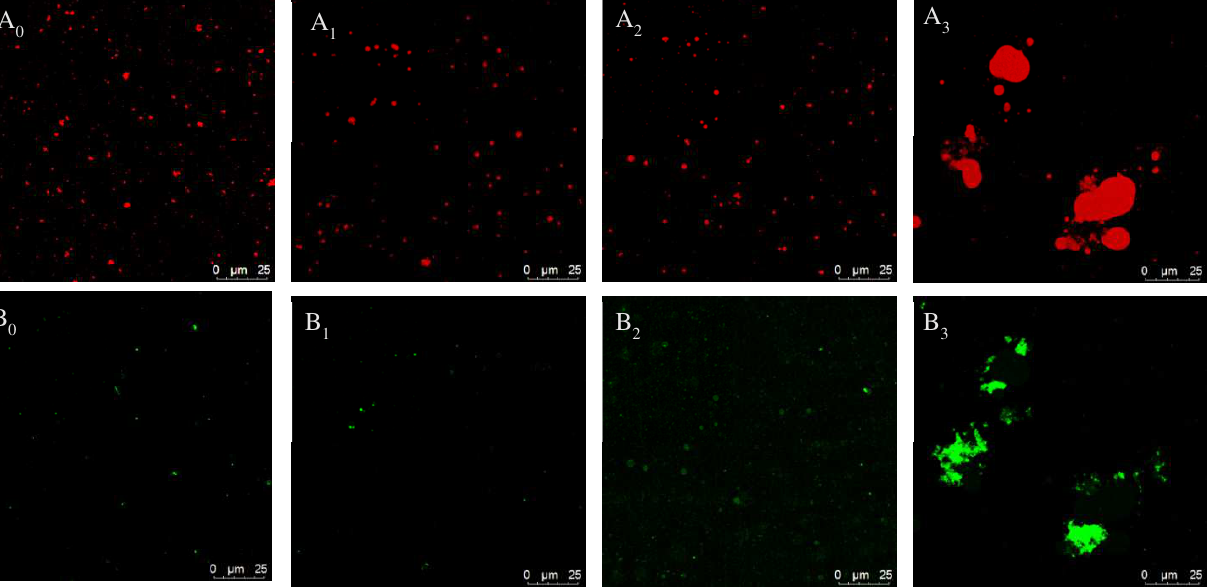
Figure 7. CLSM figures of the Pickering emulsion gels before and after three freeze–thaw cycles. ( A 0 ) initial Pickering emulsion oil phase, ( A 1 ) Pickering emulsion oil phase after one freezing thawing cycle, ( A 2 ) Pickering emulsion oil phase after two freezing thawing cycle, ( A 3 ) Pickering emulsion oil phase after three freezing thawing cycle, ( B 0 ) initial Pickering emulsion protein phase, ( B 1 ) Pickering emulsion protein phase after one freezing thawing cycle, ( B 2 ) Pickering emulsion protein phase after two freezing thawing cycle, ( B 3 ) Pickering emulsion protein phase after three freezing thawing cycle).